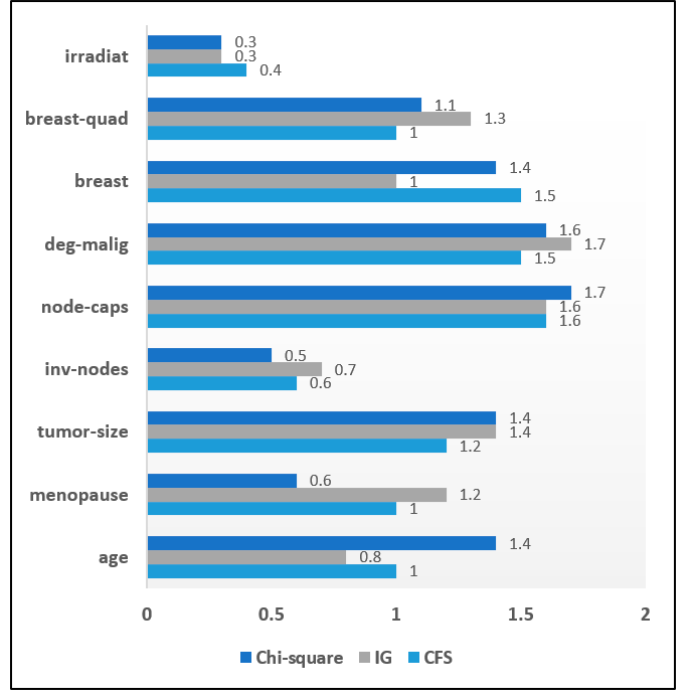
Figure 8. Attribute Significance Graph for the Breast Cancer dataset with Filters.